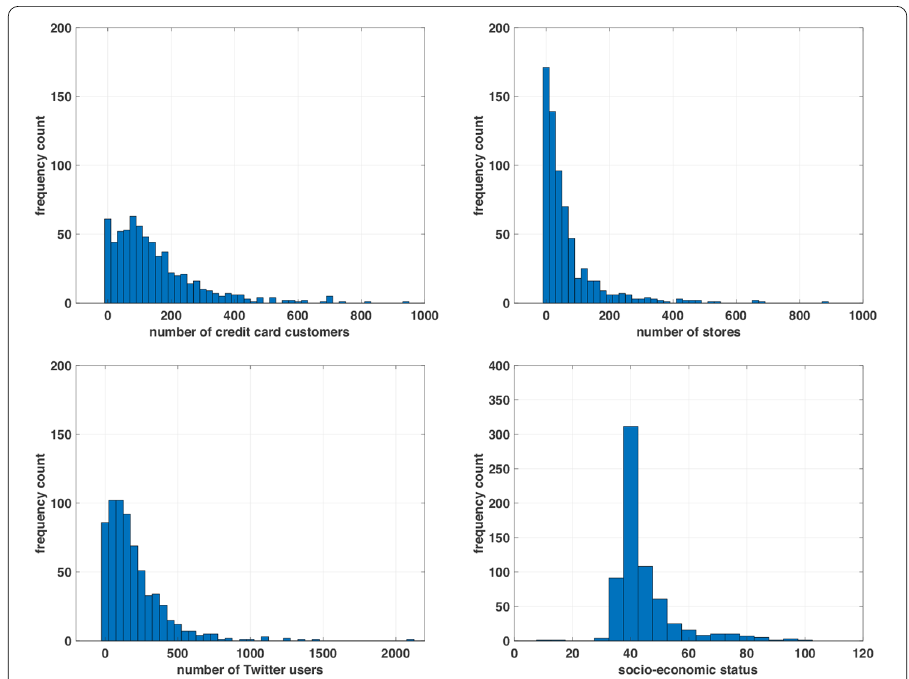
Figure 8 Histograms of (Top Left) the number of credit card customers, (Top Right) the number of stores, (Bottom Left) the number of Twitter users, and (Bottom Right) the socio-economic status, for neighborhoods in the European metropolitan